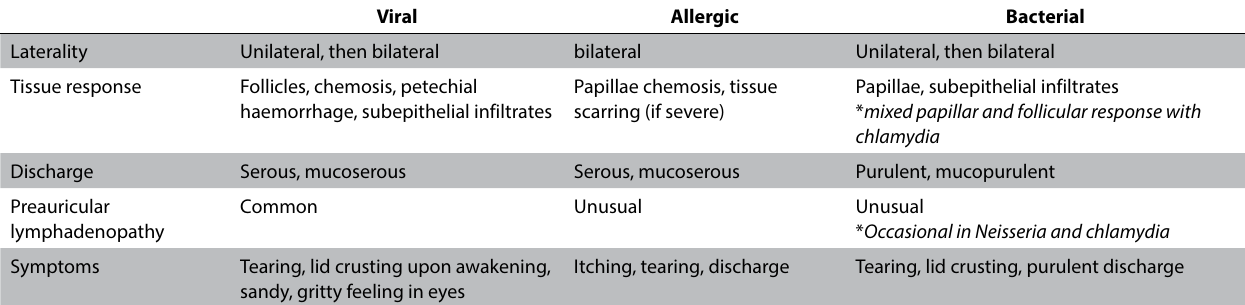
Table 2: Signs and symptoms of common types of conjunctivitis